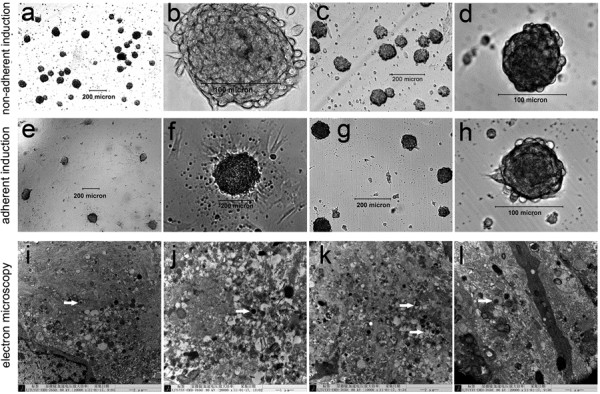
Differentiation of bone marrow mesenchymal stem cells of human first-trimester abortus into islet-like cell clusters. Many irregular cell clusters formed in the first-stage induction (A), became compact in the second-stage induction (B), and became spherical with blurred boundaries among adjacent cells in the third-stage induction, similar to the morphology of the islets of Langerhans, whereas some of the nonclustered cells adhered to the dish bottom and became similar to bone marrow mesenchymal stem cells of human first-trimester abortus in shape in the nonadherent induction group (C), (D). Irregular cell clusters after the first-stage induction (E) became hemispherical in the second-stage induction (F), uplifted with blurred boundaries among adjacent cells in the third-stage induction in the adherent induction group (G), (H), and always adhered to the dish bottom. Transmission electron microscopy showing a large number of endocrine cells (I) and secretion granules in cytoplasma of the cells in the cell clusters from the nonadherent induction group (J) and the adherent induction group (K) after the three-stage induction, histologically similar to those in fetal pancreatic islets as the positive control (L).